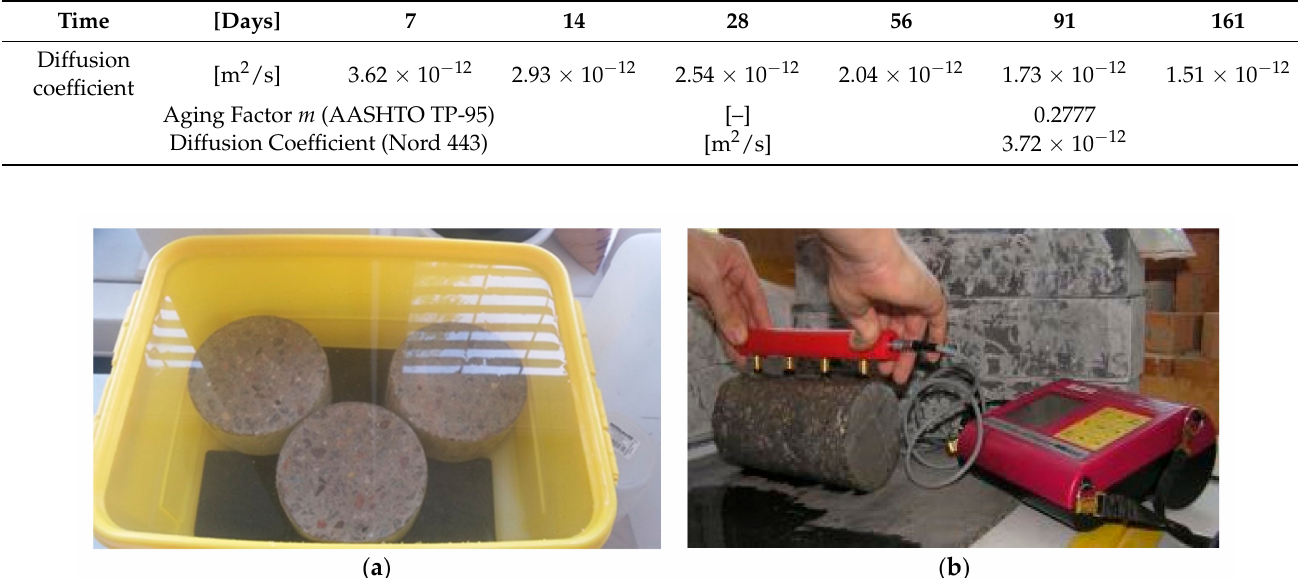
Table 5. Diffusion coefficient and aging factor—HPC2.